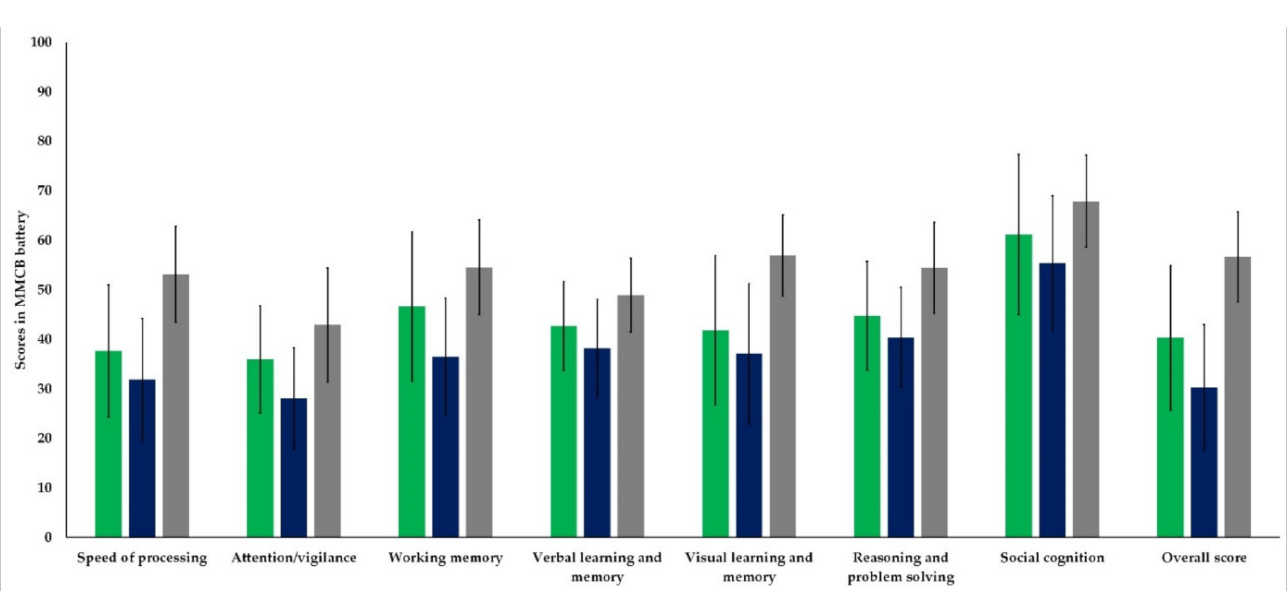
Figure 1. Profile of comparison of cognitive domains measured by MMCB battery between partici- pants from three groups. MMCB = MATRICS Consensus Cognitive